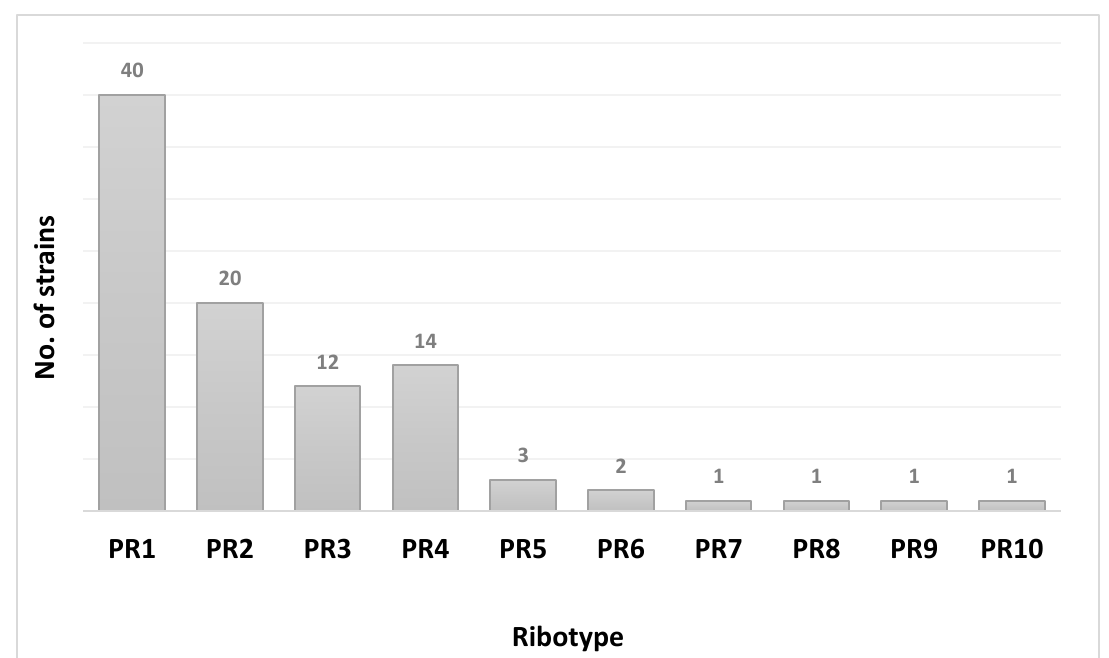
Figure 1. Different Clostridioides difficile ribotypes found in the study period.